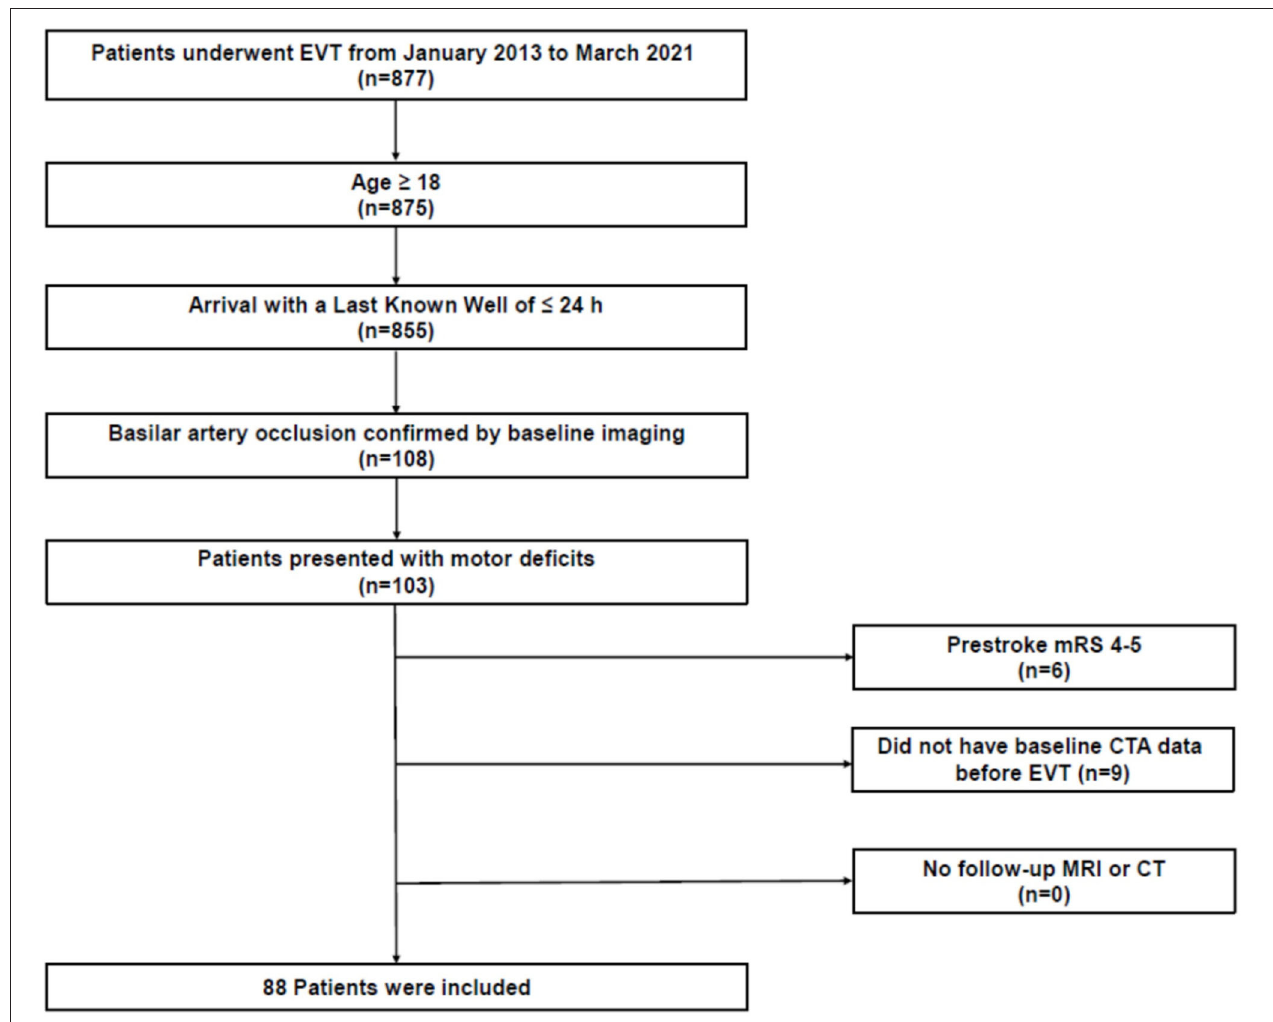
FIGURE 1 | Study flowchart. CT, computed tomography; CTA, CT angiography; EVT, endovascular treatment; MRI, magnetic resonance imaging; mRS, modified Rankin